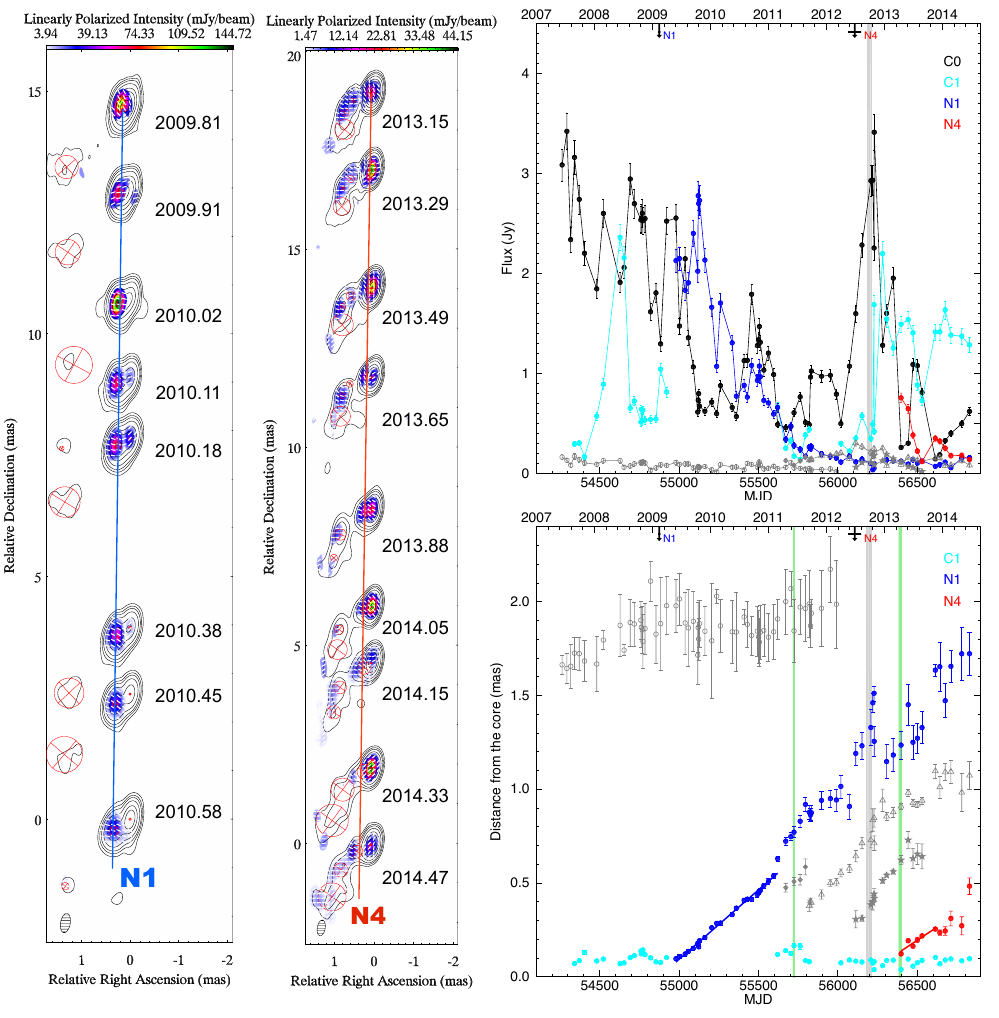
Figure 3. Left and center: Sequence of total intensity (in contours) and linearly polarized intensity (in colors) 43 GHz VLBA images of CTA 102. Contours are traced at 0.003, 0.008, 0.04, 0.1, 0.3, 0.6, 1.2, 1.8, 2.5, and 3.0 Jy beam − 1 . The images show the appearance of components N1 and N4. Red circles represent model-fits components; Right: Light curves ( top ) and distance from the core vs. time for the 43 GHz model-fit components. The grey vertical line corresponds to the main γ -ray flare and the green ones to the minor γ -ray flares in June 2011 and April